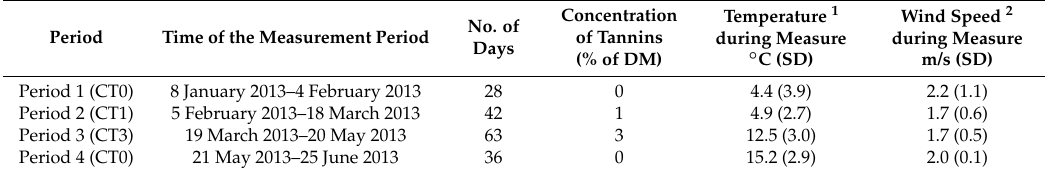
Table 1. Description of the measurement periods and conditions (average values of each measurement period for both barn sections). DM: dry